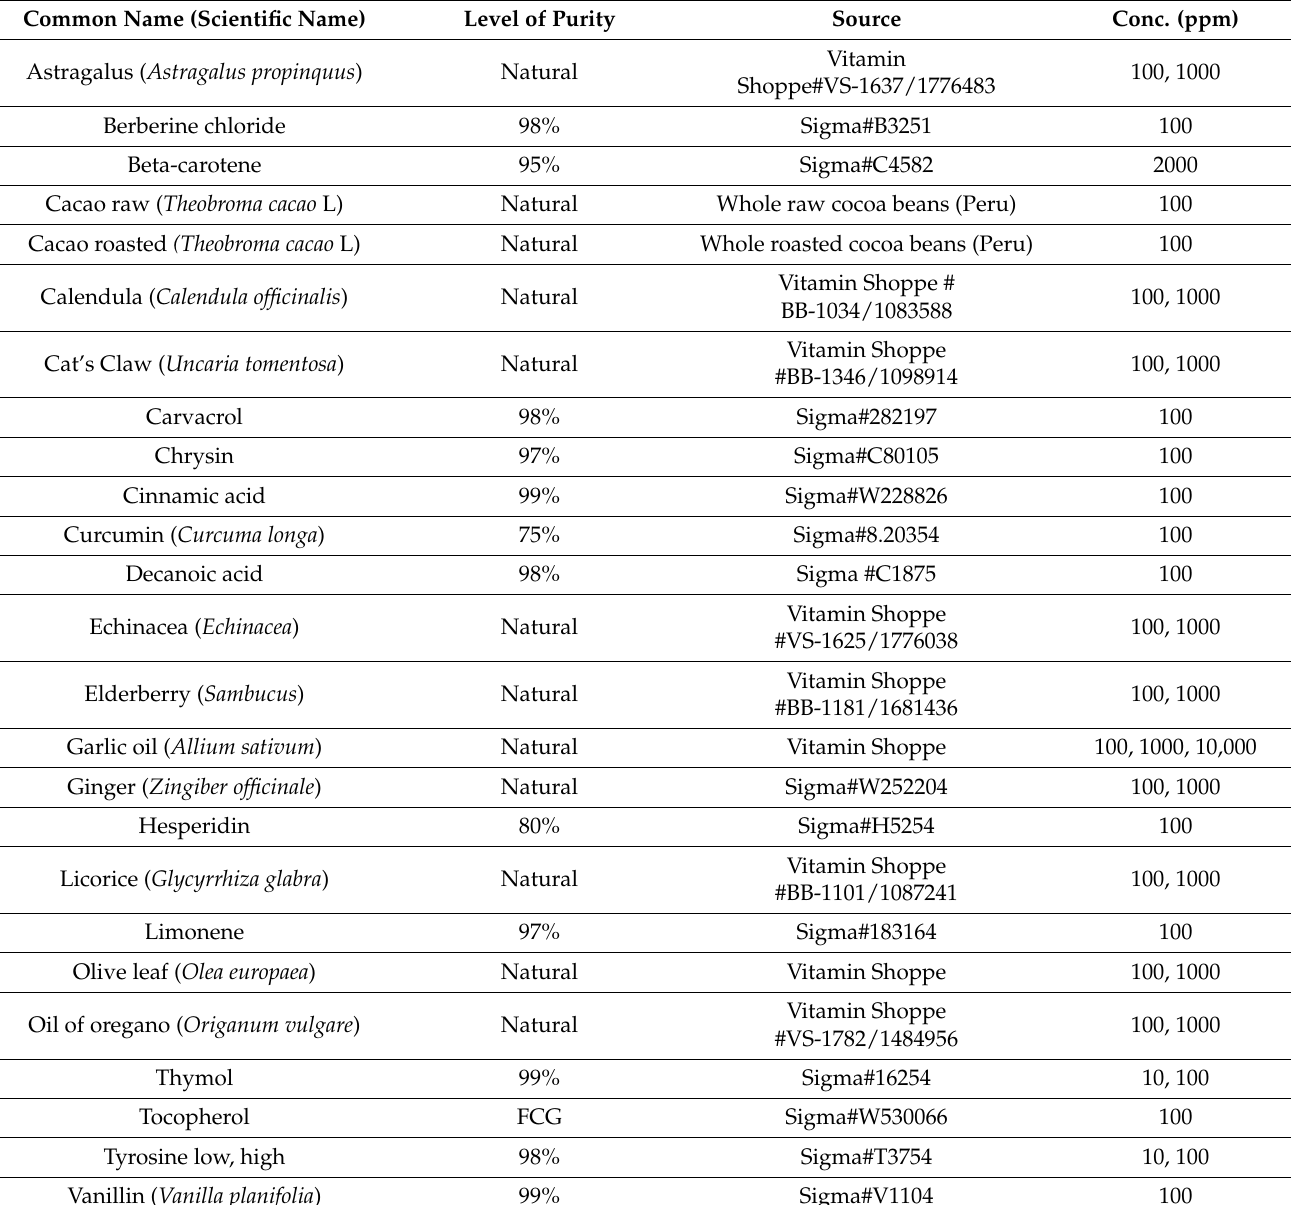
Table 1. Natural product sourcing and tested